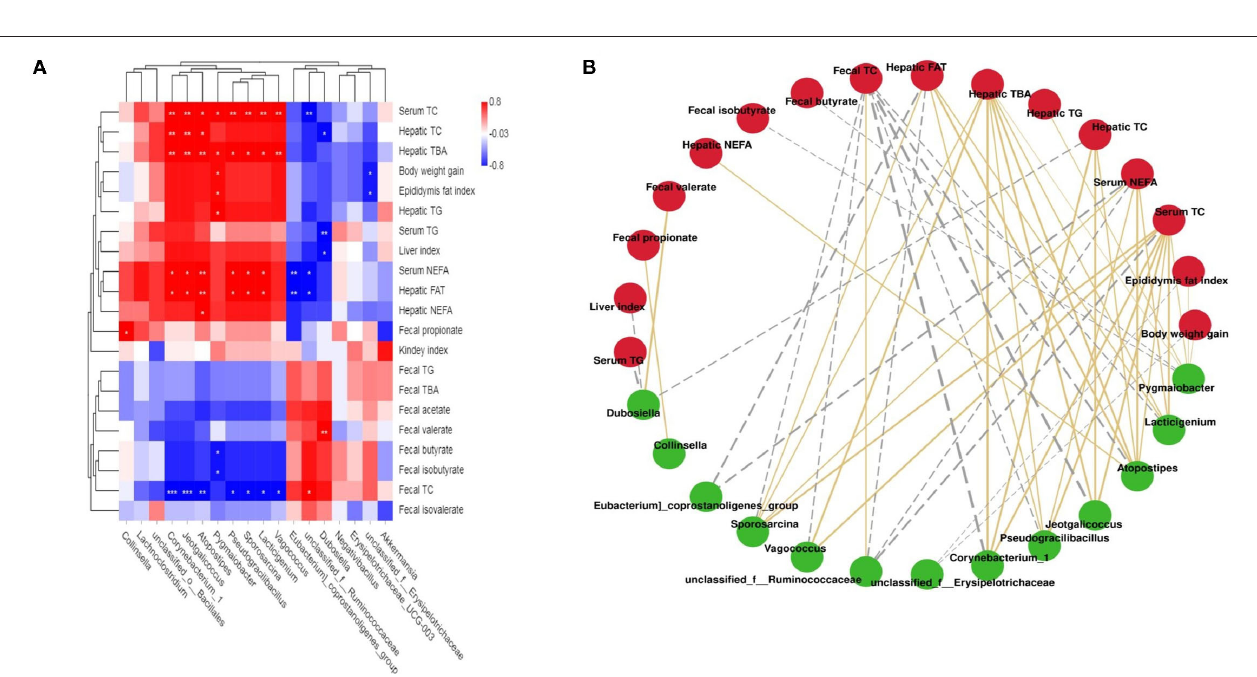
FIGURE 6 | Statistical Spearman’s correlations between the fecal microbiota of significant differences and lipid metabolic parameters. (A) Heatmap of Spearman’s correlation. The intensity of the color represents the degree of association; (B) Correlation network constructed between bacterial species and microbial metabolic pathways. The edge width and color (gold: positive and gray: negative) are proportional to the correlation strength.